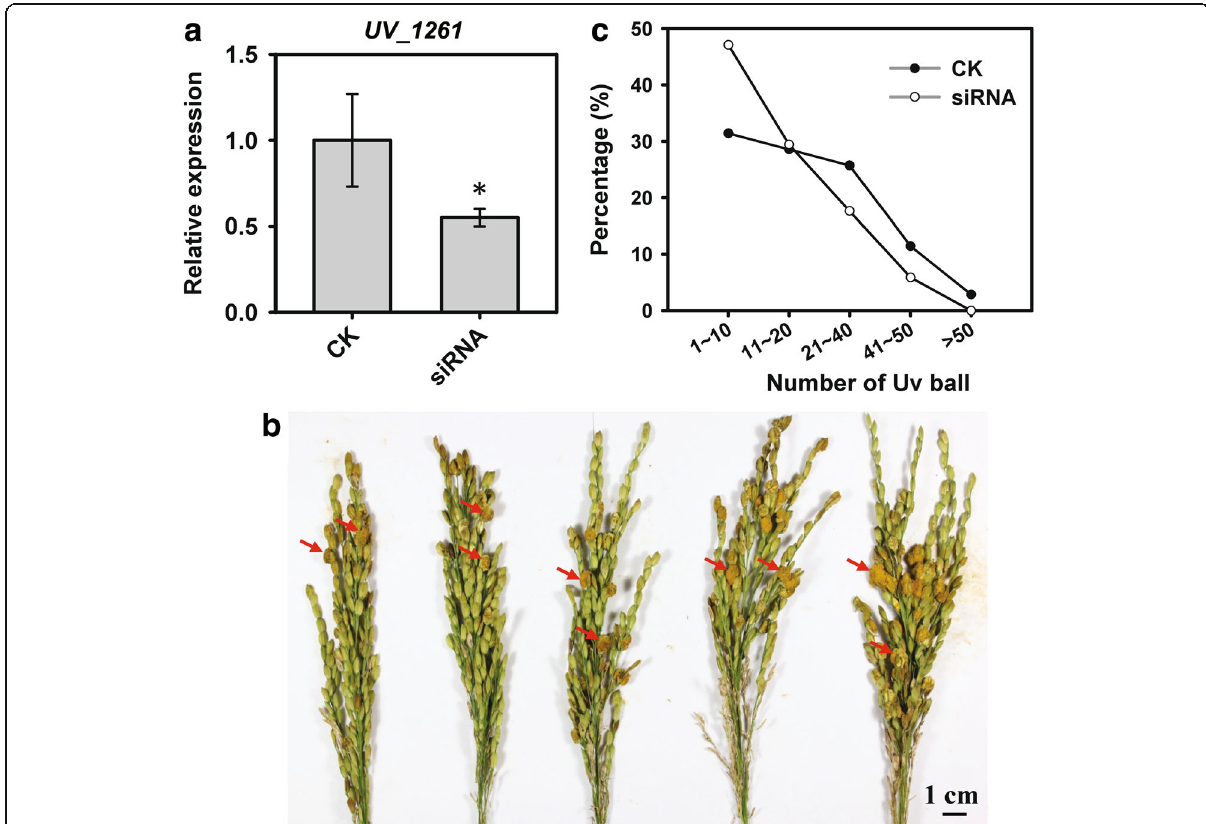
Fig. 4 In vitro application of double-stranded siRNA of UV_1261 to U. virens P4. a Double-stranded siRNA specifically targeting UV_1261 was synthesized in vitro and added in PSB culturing U. virens isolate P4. Relative expression of UV_1261 was determined by RT-qPCR using UvTub2 α as a reference gene. Significant difference was determined by the Student ’ s t-test. **, P < 0.05. b Representative image of P4-infected rice panicles with variable number of false smut balls. c The number of false smut balls in P4-infected rice panicles. P4 inocula were pre-treated with 10 nM double-stranded siRNA of UV_1261 , and adding with DEPC-treated ddH 2 O was set as control (CK). Arrows indicate false smut balls. Uv, U.